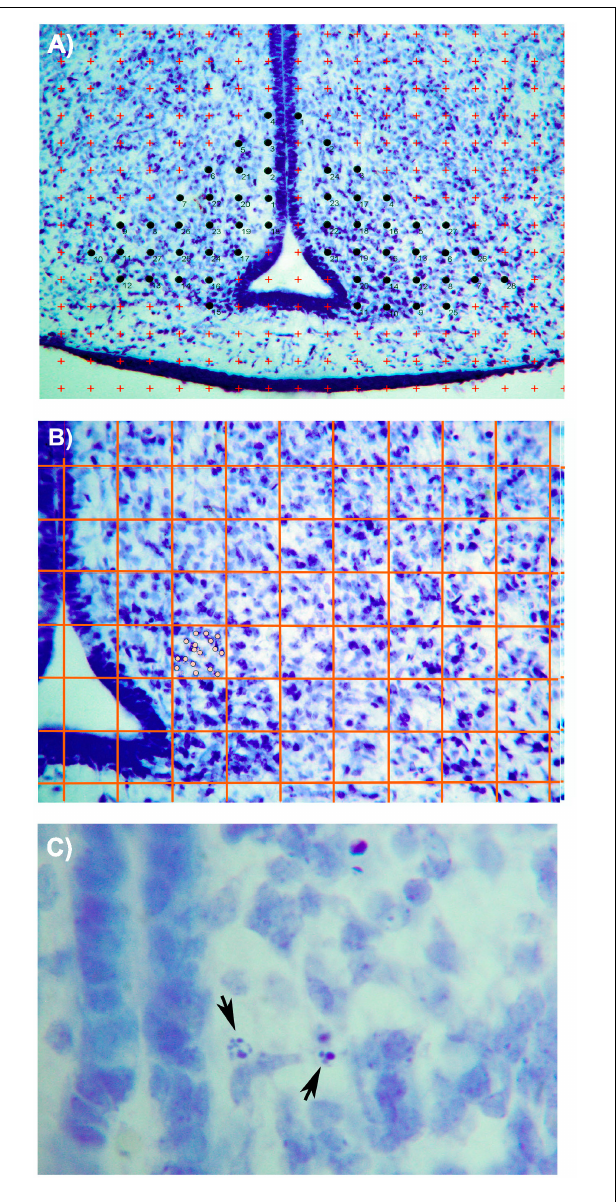
FIGURE 1 | Photomicrographs ( × 10) showing (A) the Cavallieri method used for the estimation of ARC volume in Nissl-stained sections. Briefly, a grid of red crosses of 2,000 µ 2 was overlaid on the photo. All crosses that are contained within the limits of the nucleus were counted (marked with black circles). (B) Method applied for counting neurons in the ARC section. A grid of red lines (these lines have been amplified in the photograph for an easier identification of the grid) was generated, covering all the sections. Each box has 0.04 µ 2 size. As seen in the photo, all neurons (marked as gray circles) included within the limits of the box were considered. (C) Photomicrograph ( × 100) showing apoptotic activity in the ARC nucleus. Black arrows show two cells in different phases of the apoptotic process. Bar = 200 µ m (Paxinos et al., 1994).